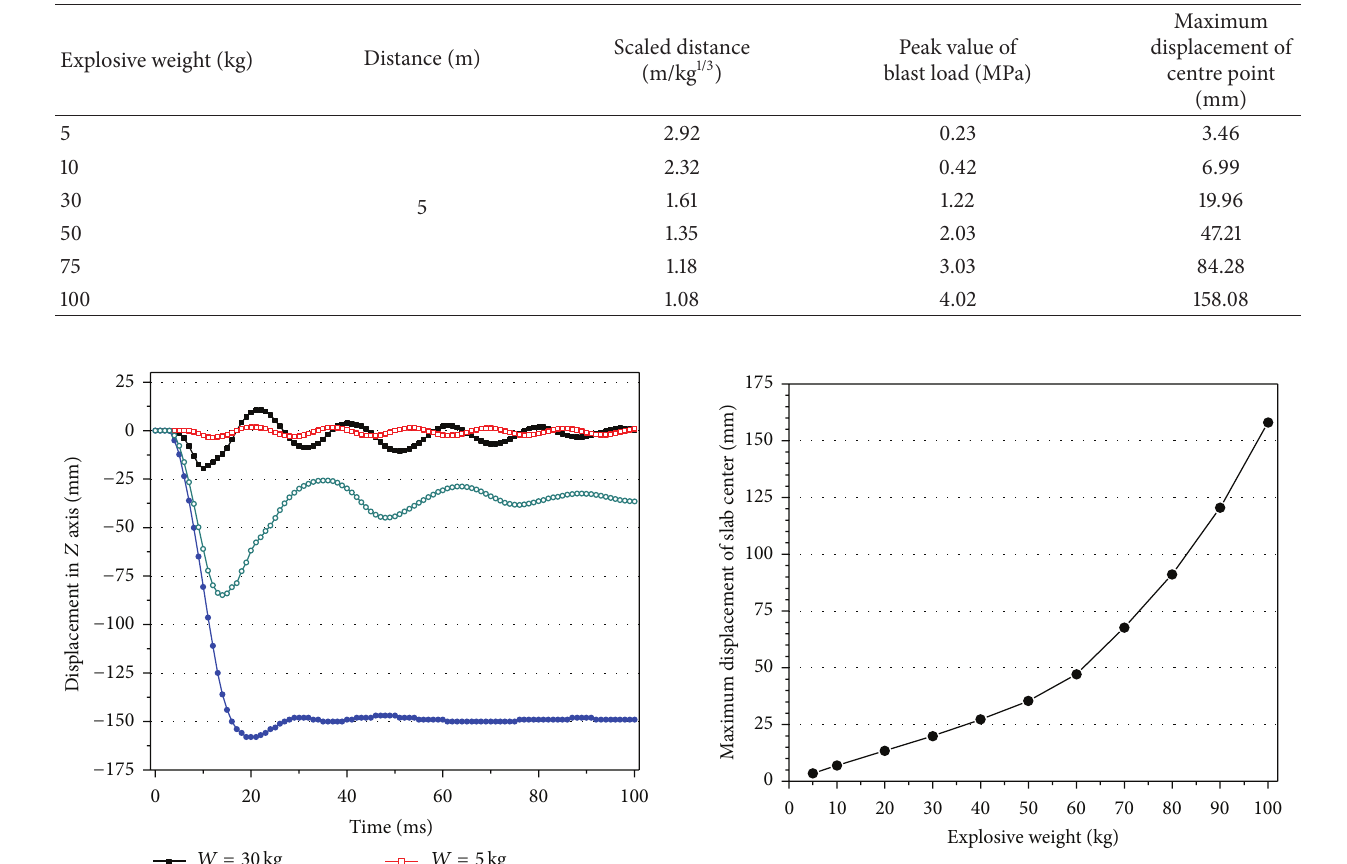
Figure 7: Maximum displacement of RC slabs under different explosive